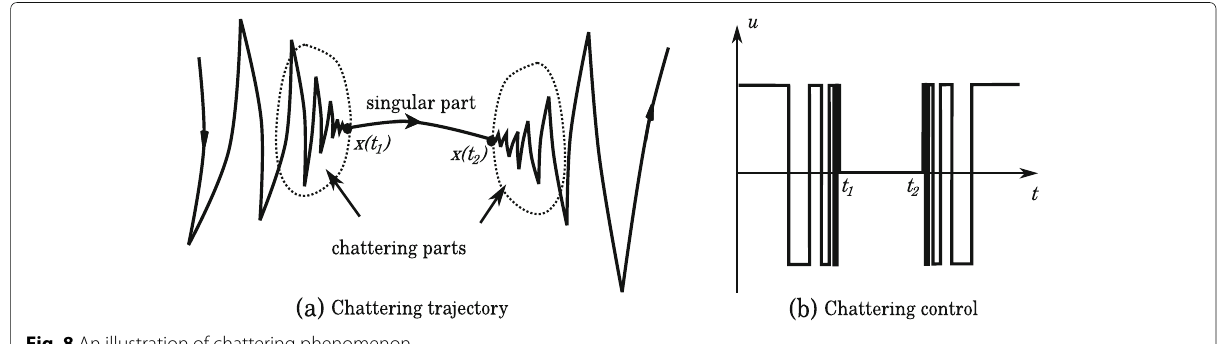
Fig. 8 An illustration of chattering phenomenon